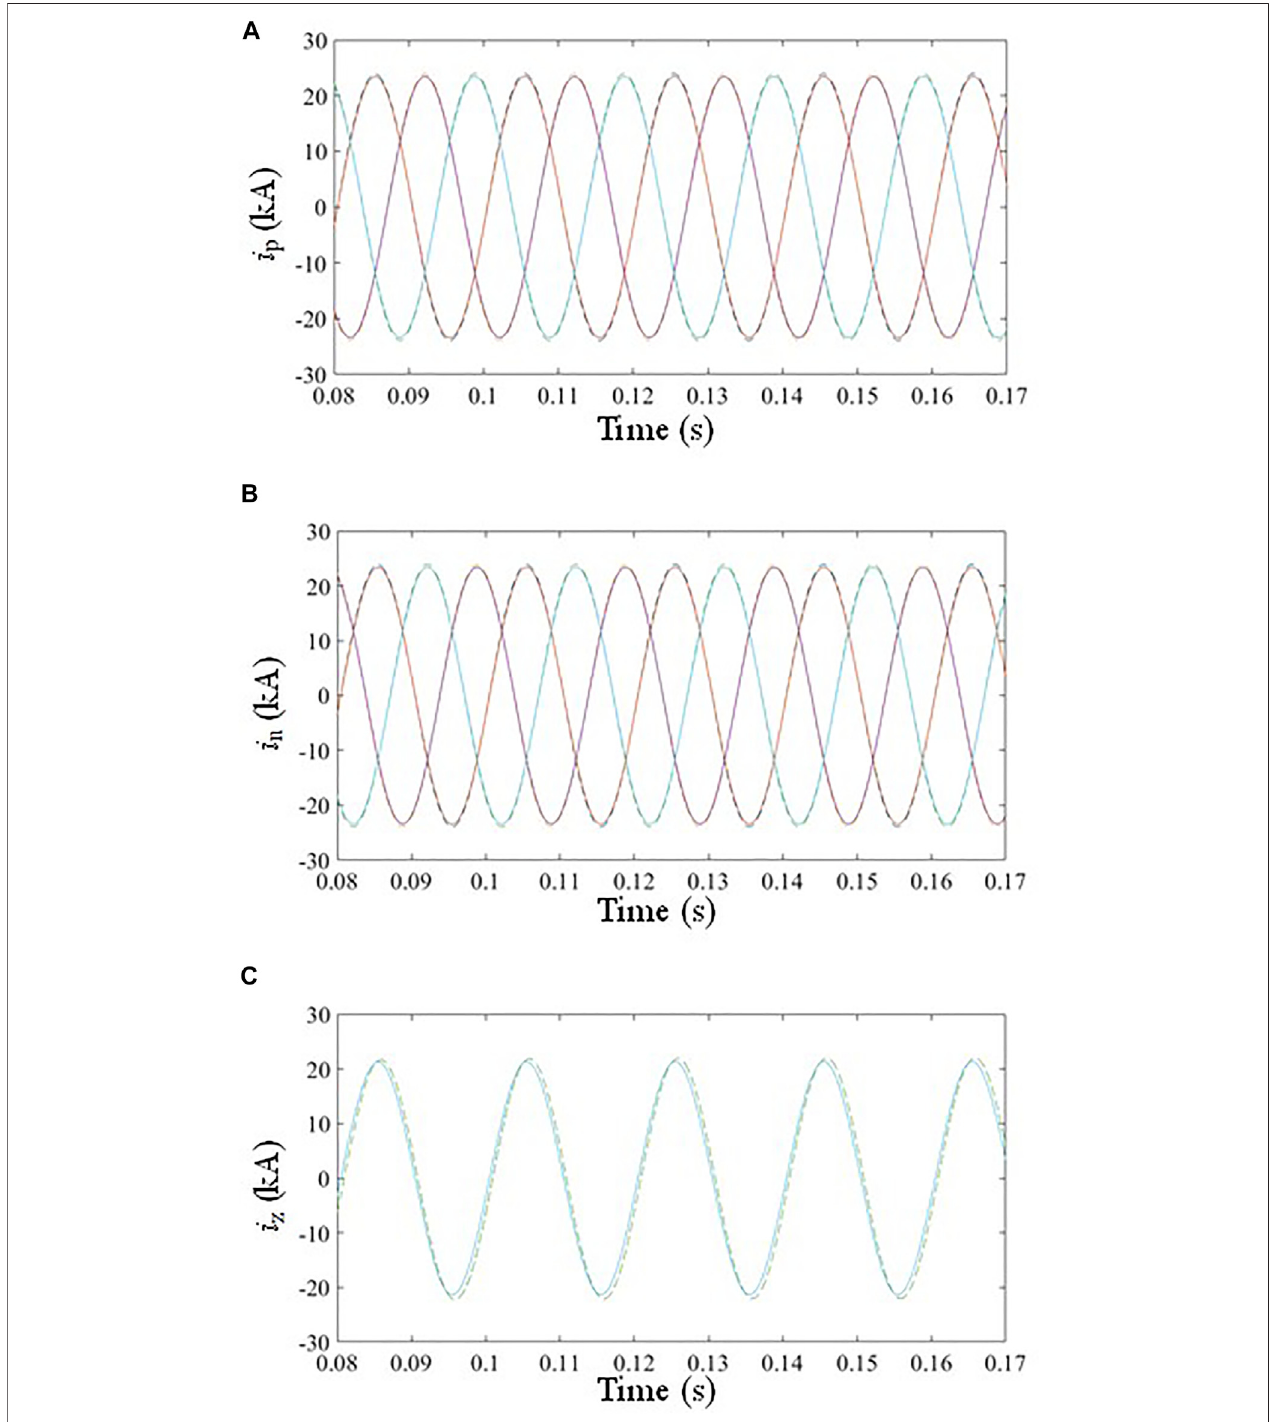
FIGURE 7 | Three-phase current waveform on the N side. (A) Positive sequence current of three phases, (B) Negative sequence current of three phases, (C) Zero sequence current of three phases.